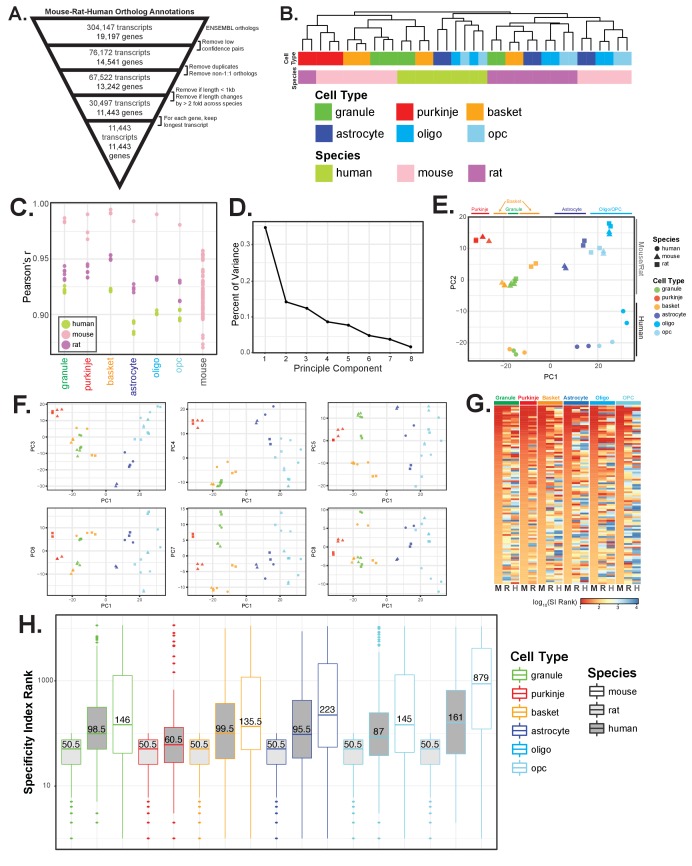
Comparative analysis of gene expression in specific cell types of mouse, rat, and human, related to Figure 3.(A) Schematic for defining ortholog annotation for mouse, rat, and human genes. Ortholog annotation across species were downloaded from ENSEMBL, filtered to include only high confidence pairs, 1:1 orthologs, genes greater than 1 kb in total length, and genes that change by less than 2-fold in length across species. For each gene, the longest orthologous transcript was used for annotation. (B) Hierarchical clustering of mouse, rat, and human cell-type specific datasets based on expression of all genes instead of the top 250 most variable genes reveals clustering primarily by species. (C) Dot plot showing pairwise Pearson’s correlation coefficient for each sample, broken down by cell type. Last column shows the pairwise Pearson’s correlation coefficient between all cell types in mouse. (D–F) Principal components analysis of all datasets. (D) Plot showing the percent of variance explained by each of the first eight principal components. (E) Scatterplot showing values of the first two principal components (PC1, PC2). PC1 separates samples based on cell type while PC2 separates mouse and rat from human samples. (F) Scatterplots showing the first principal component versus components three through eight. (G-H) Specificity index (SI) analysis of cell-type specific genes in mouse, rat, and human. SIs for each species were computed separately using the set of genes with high confidence 1:1 orthologs across all three species as defined in (A). For Purkinje neurons, SIs were computed in mouse and rat using all 6 cell types. For the other five cell types, SIs were computed in mouse, rat, and human using only these 5 cell types. (G) Heatmap showing SI calculated ranks. Shown are the top 100 mouse SI genes for each cell type. Colors indicate log10 rank position of these 100 genes in mouse, rat, and human. (H) Boxplot representation of SI ranks from (G).